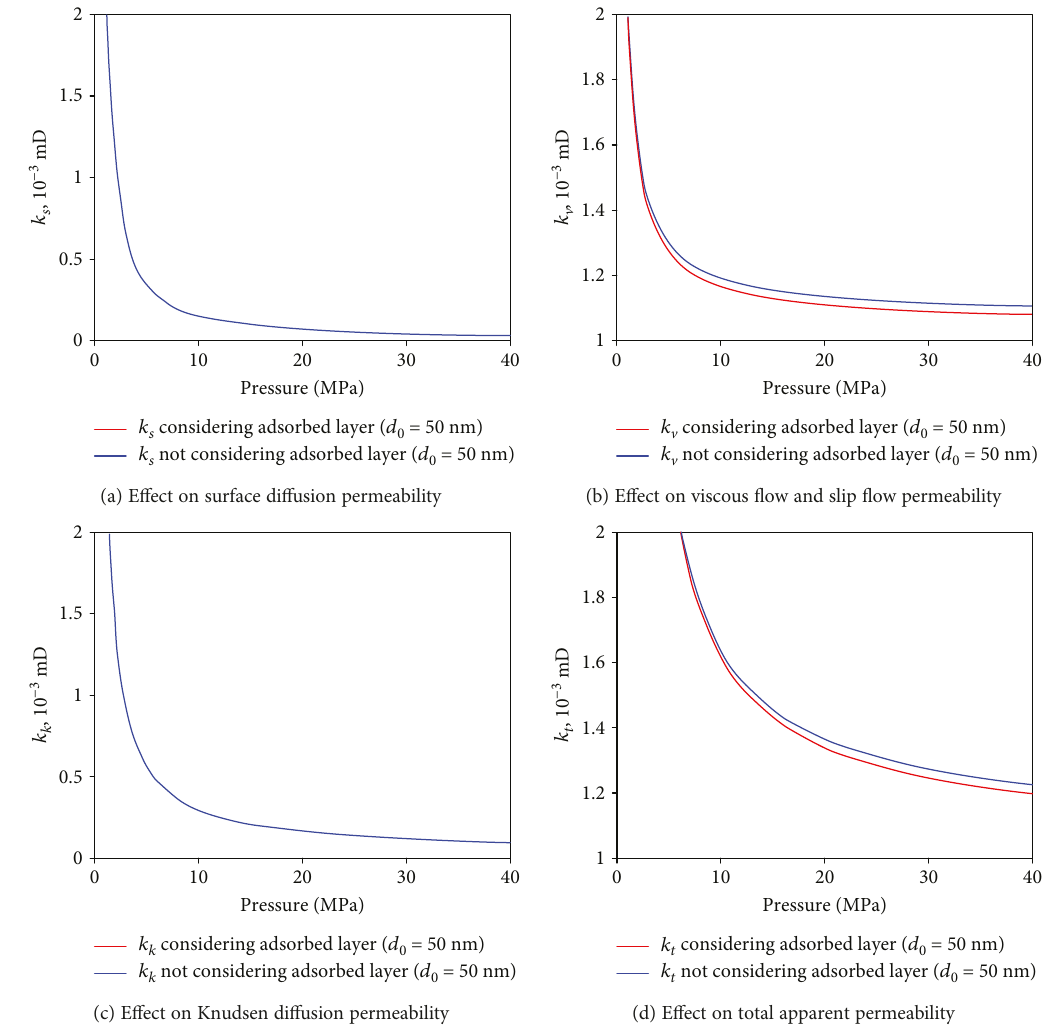
Figure 14: The e ff ect of adsorbed layer on apparent permeability of shale (pore diameter = 50 nm